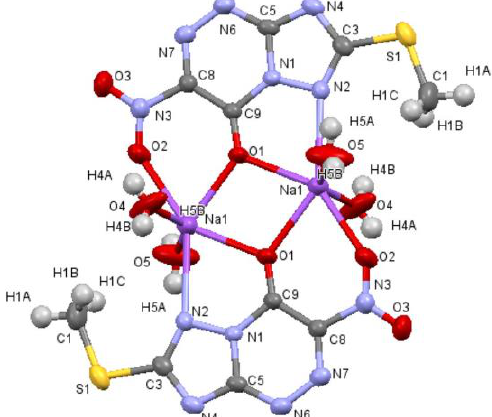
Figure 1. View of the dimeric structure, drawn with 50% probability displacement ellipsoids and showing the atom labeling. H-atoms are shown as small spheres of arbitrary radii. Reprinted/adapted with permission (license 5427551466931) from [30], 2018, Springer Nature. Triazavirin with several isotopic labels, bearing 2H, 13C, and 15N atoms, was first synthesized according to Scheme 4 in order to study the metabolism of the drug [31,32].